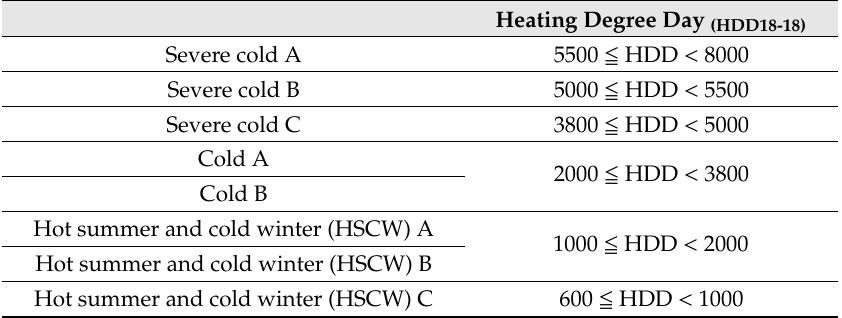
Table 9. Chinese heating degree day (HDD 18-18 ) classification (Huang and Deringer, 2007).